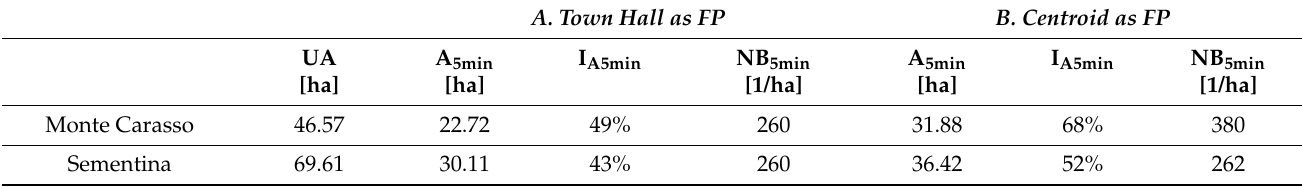
Table 2. Pedestrian accessibility parameters of Monte Carasso and